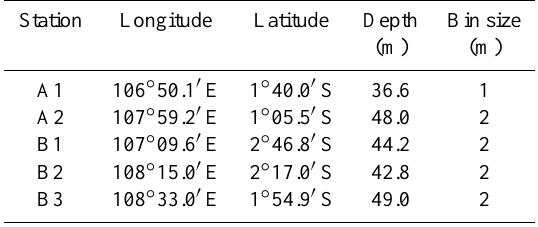
Table 1. Locations and water depths of the observational stations.